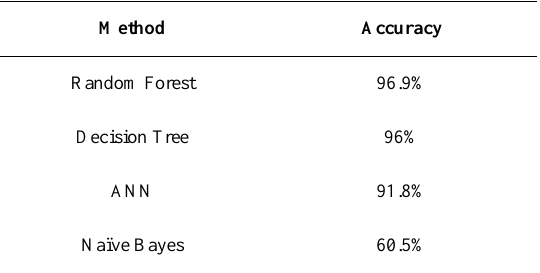
Table 3. Accuracy results from different methods.